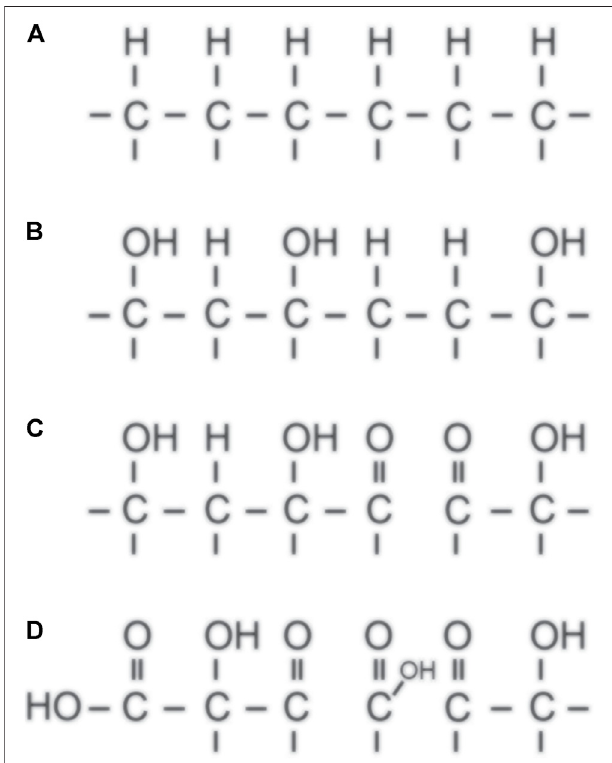
FIGURE 5 | Shematic of the evolution of the surface functional groups on polyole fi n as predicted by theory and con fi rmed experimentally. Untreated polyole fi n (A) is fi rst functionalized with OH groups (B) , and treatment at larger O-atom fl uencescausestheformationofC=O (C) andO-C=Ogroups (D) .